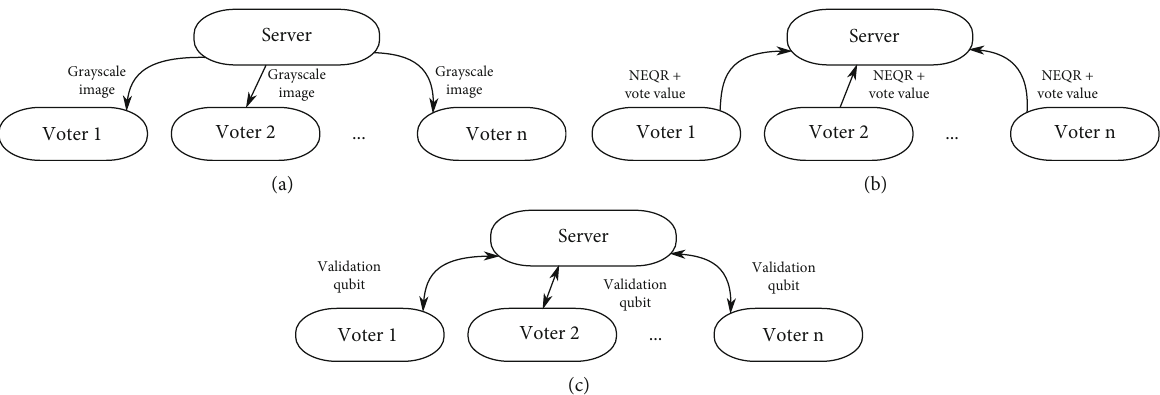
Figure 2: The proposed voting scheme. (a) Step 1: the voters fi rst receive a grayscale image from the server. (b) Step 2: the voters create the NEQR representation of the pixels in the corners of the image. For each voter, the qubits representing the LSB denote the operation gate that needs to be applied to the voter ’ s value circuit (the superdense coding circuit) so that the server can retrieve the actual vote. (c) Step 3: once each voter fi nishes setting the value qubit, he can set the validation qubit to j 1 i ; this indicates to the server that the voter expressed his option and can now add it, after the measurement, to the fi nal count.